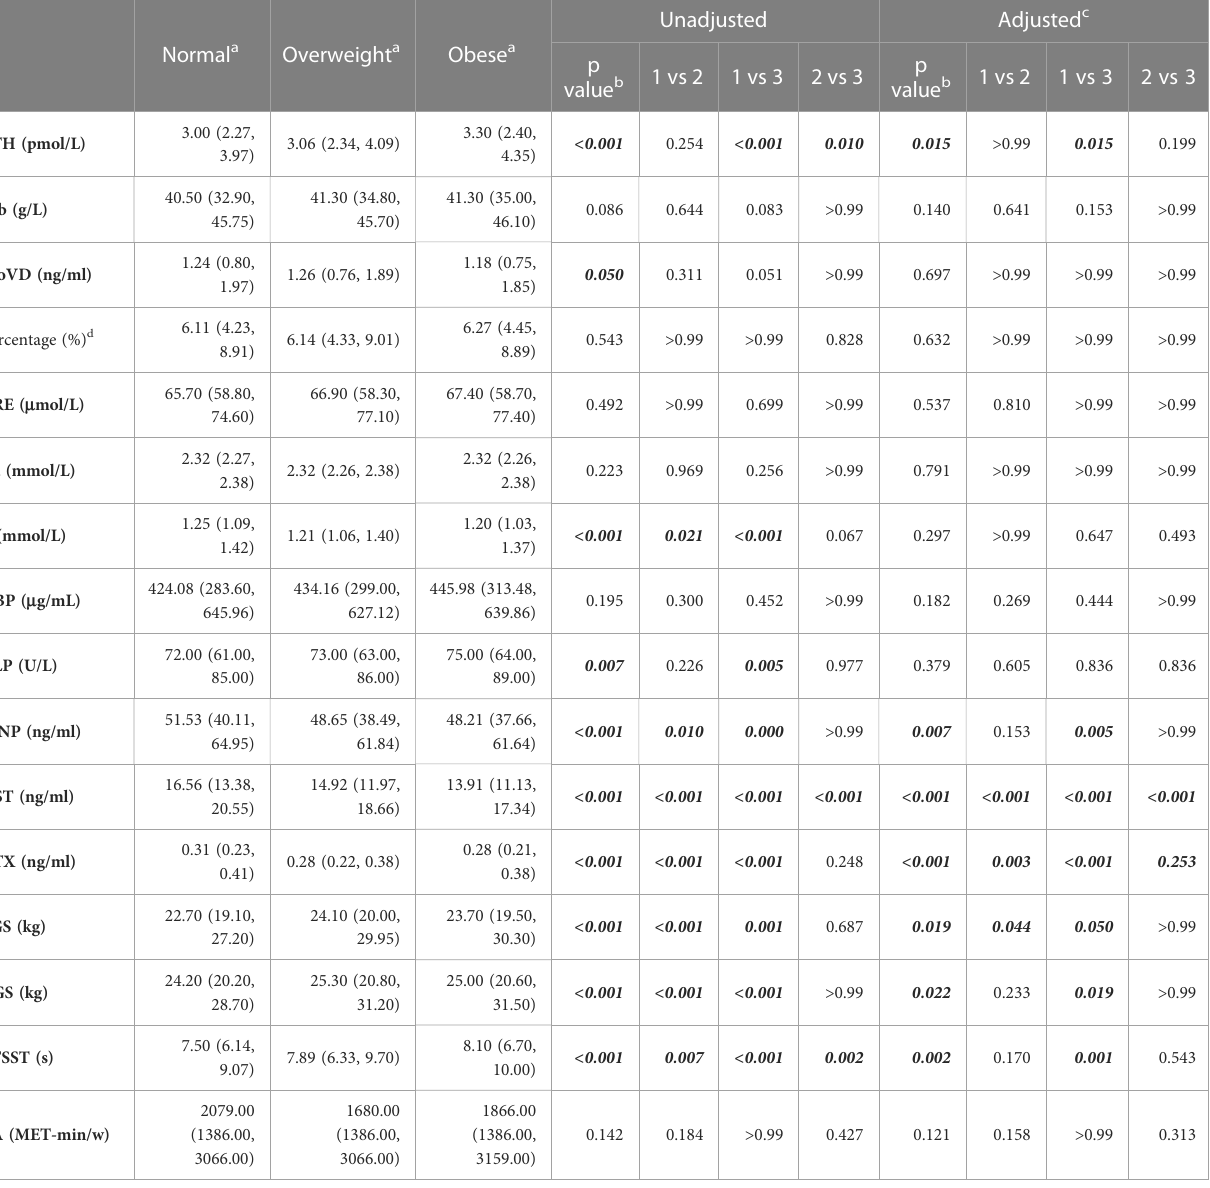
TABLE 2 Comparision of serum biomarkers and physical measurements among different BMI participants.